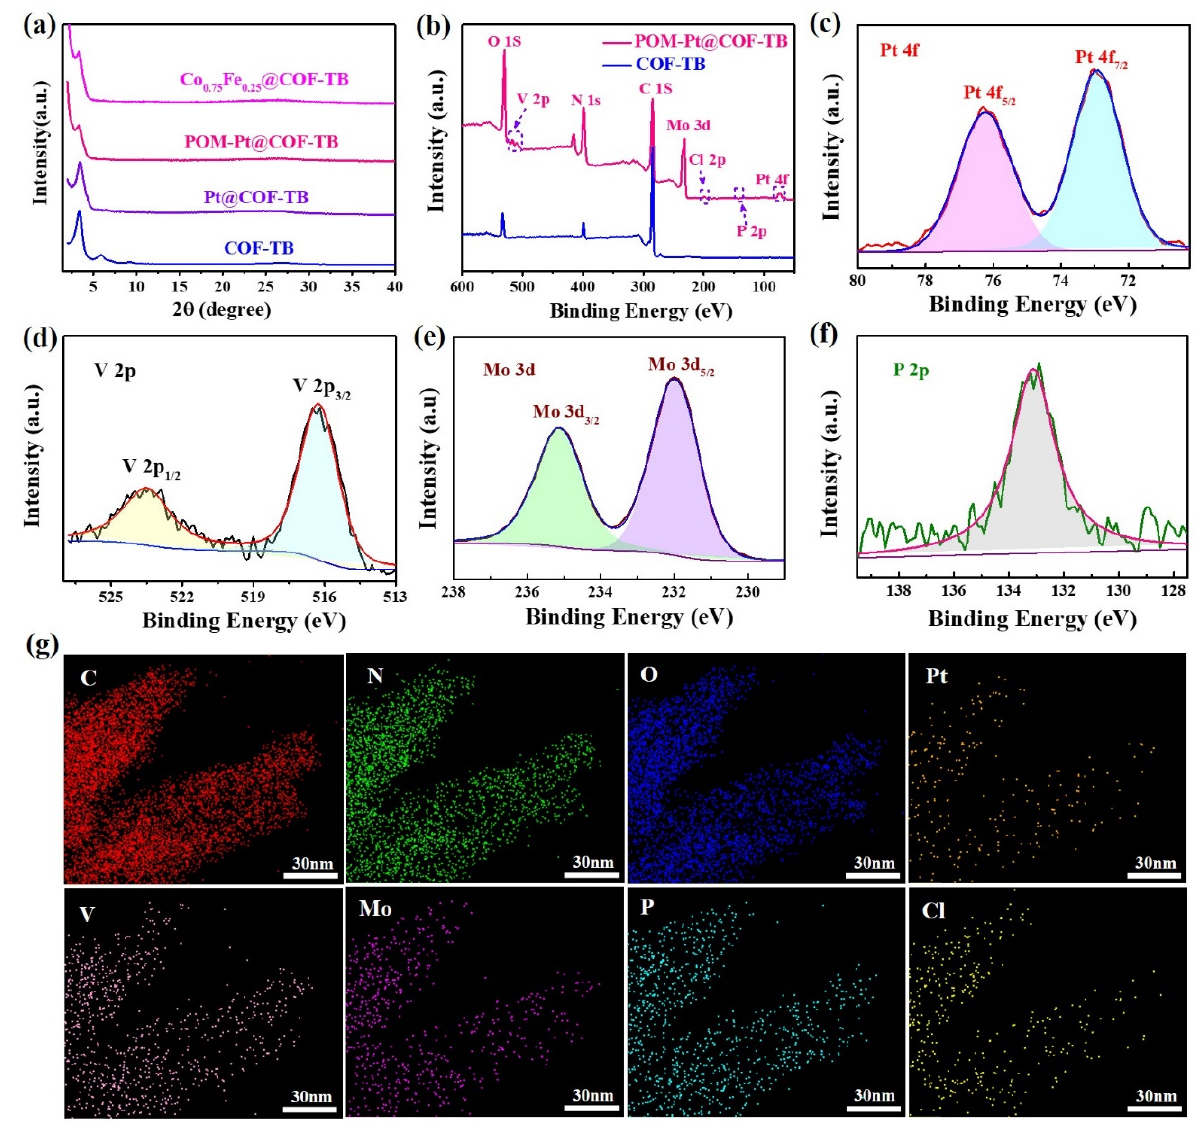
Figure 1. ( a ) Powder X − ray diffraction (PXRD) patterns of prepared COFs; XPS spectra